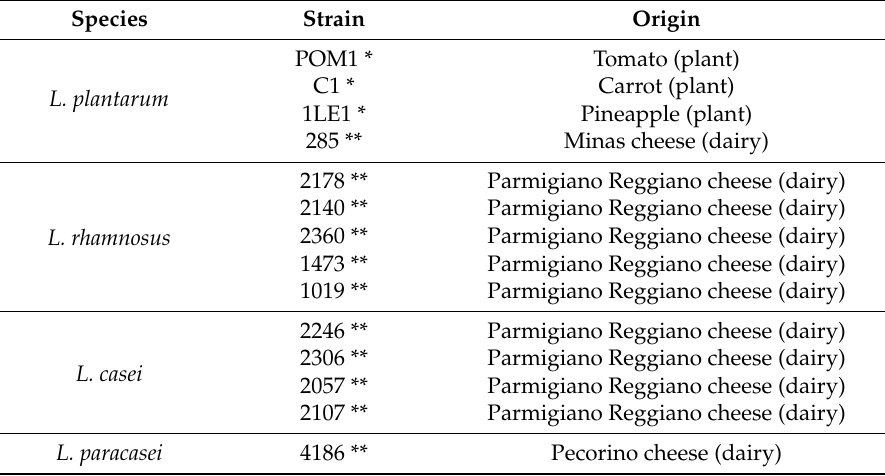
Table 1. Microbial strains used in the study and their